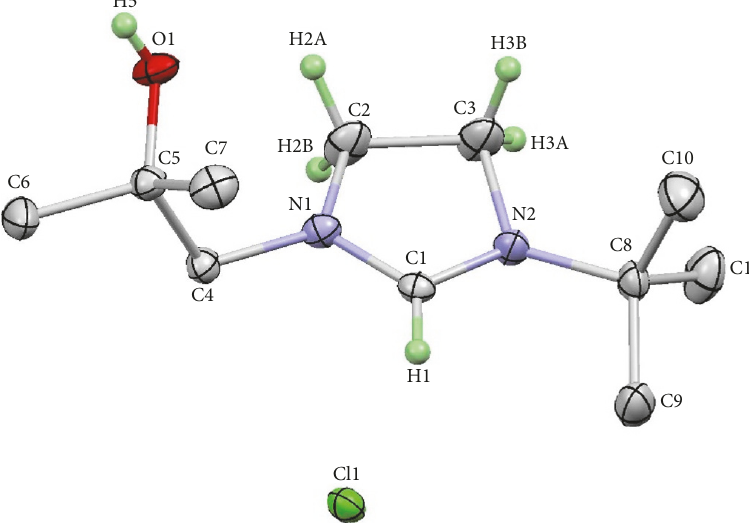
Figure 2: Molecular structure of 3 . Thermal ellipsoids set at 50% probability. Hydrogen atoms except for those attached to C1 – C3 and O1 are omitted for clarity. Selected bond lengths (˚A) and angles ( ∘ ): C1-N1 1.311(3), N2-C1 1.323(3), C2-C3 1.530(4), N1-C1-N2